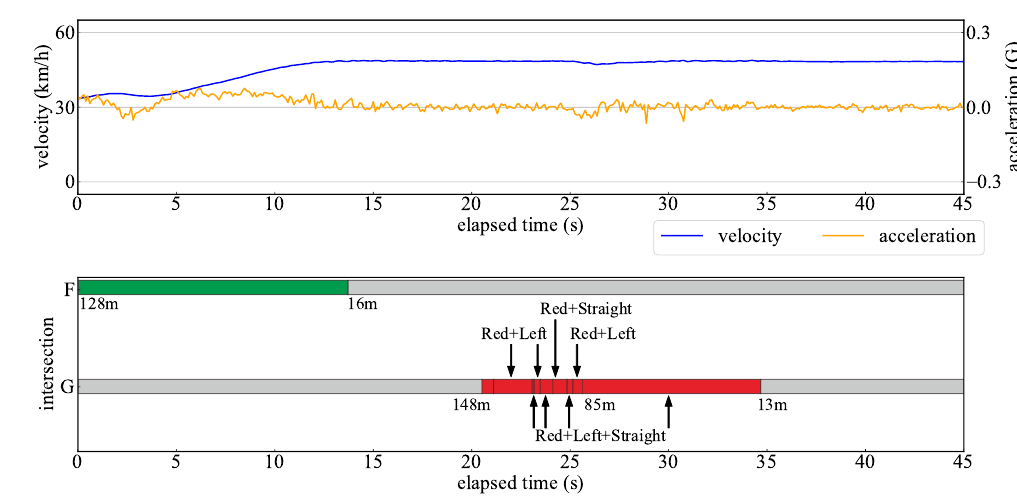
Figure 22. Verification results for automated driving from the intersection A to E.